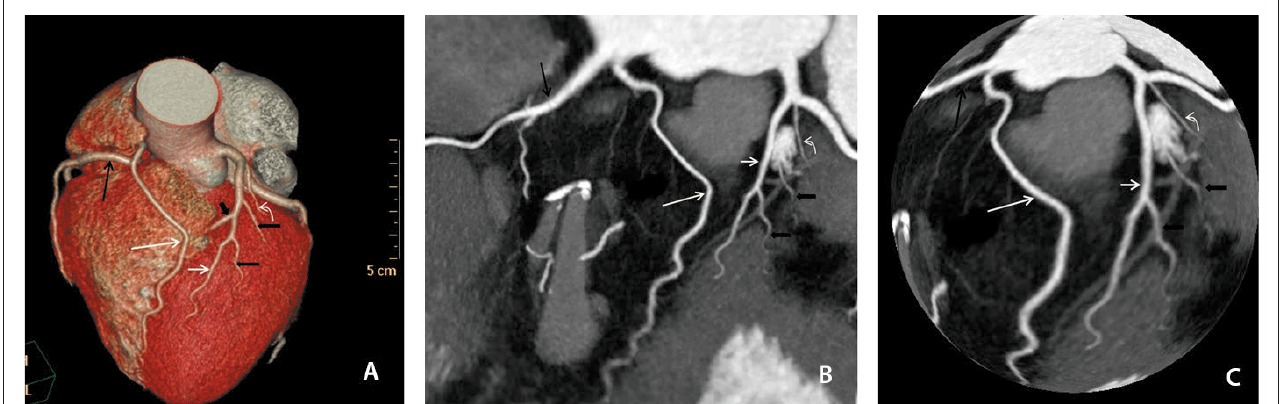
Fıg. 1. (A) Three-dimensional volume-rendered (3D-VR) image. (B) Two-dimensional map of the coronary tree. (C) Maximum intensity projection 3D-globe view. Long LAD (long white arrow) has anomalous origin from the right coronary artery (long black arrow) and after travelling anterior to the pulmonary artery and right ventricle, enters the AIVS at the distal part. Short LAD (short white arrow), which terminates high in the AIVS arising from the left main coronary artery. The major septal perforator (short thick black arrow) as well as the diagonal branches (short thin black arrows) originate from this short LAD. Ramus intermedius identified by curved